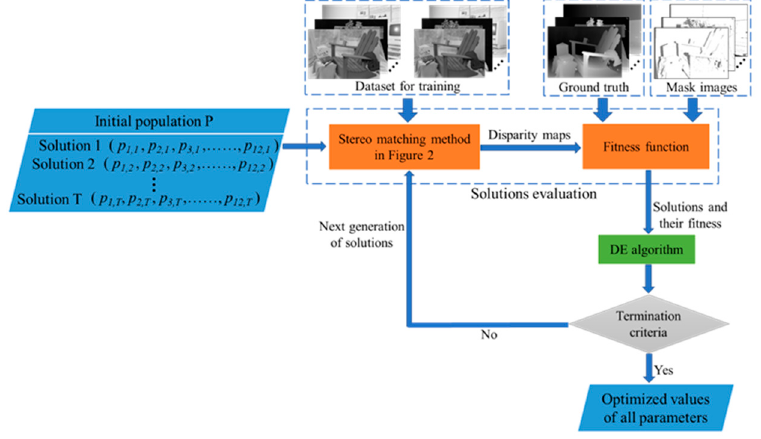
Figure 3. The flowchart of the parameter optimization method based on DE algorithm.